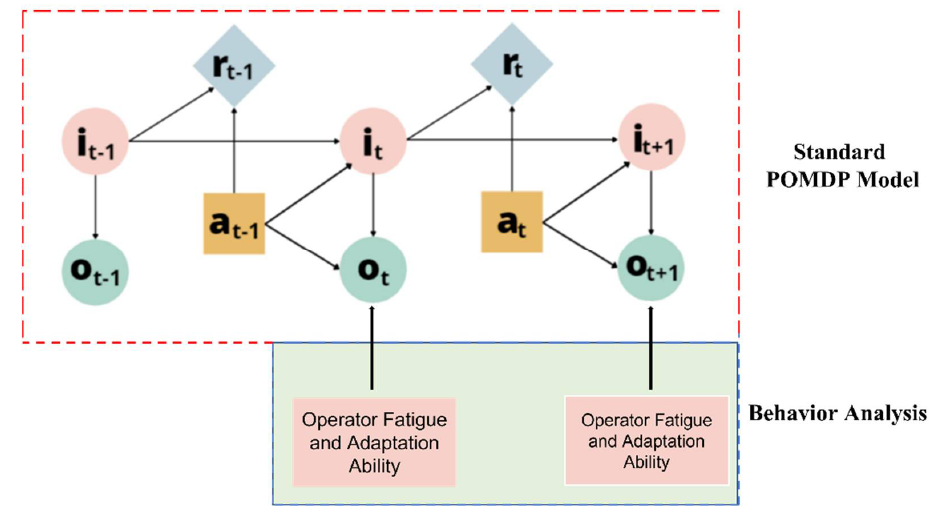
Figure 3. A Breakdown of POMDP framework with Behavior Analysis.